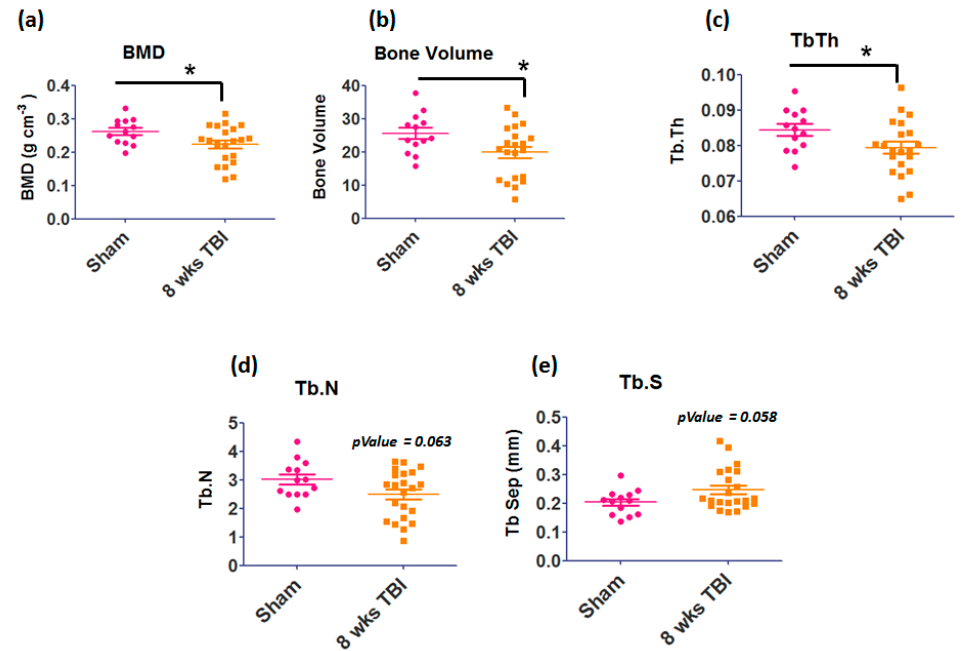
Figure 1. Representative cresyl violet-stained coronal brain sections from sham and TBI mice at 48 h.